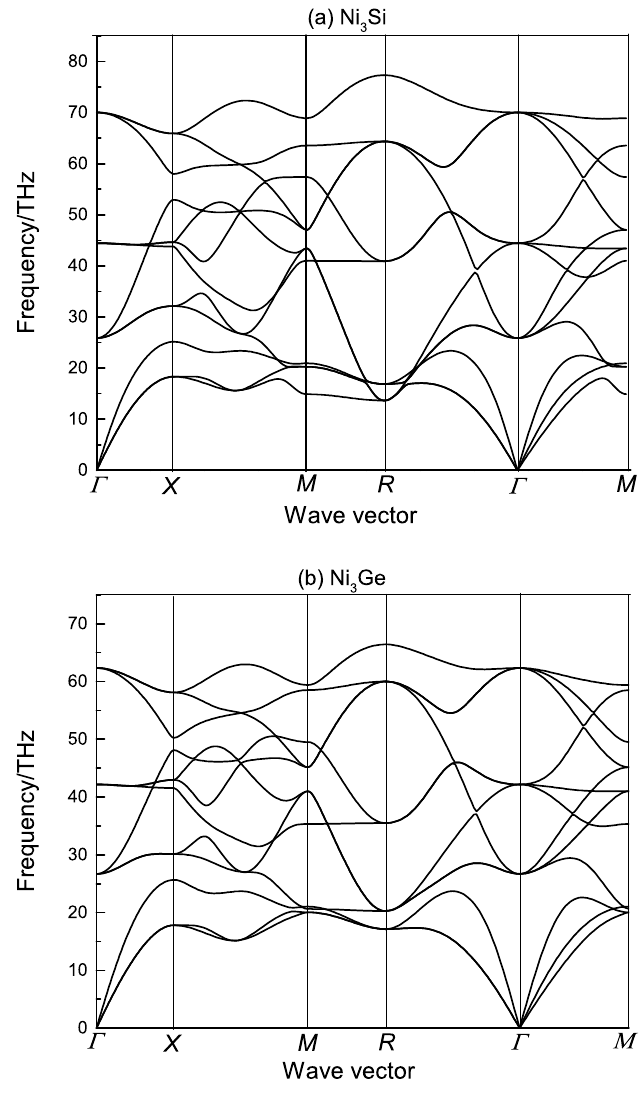
Figure 1. Phonon spectra of ( a ) Ni 3 Si and ( b ) Ni 3 Ge along high-symmetry directions in the Brillouin